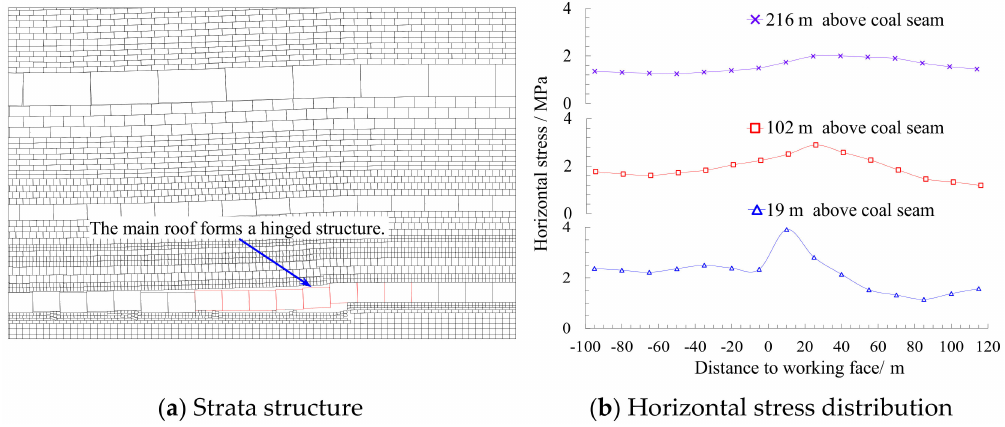
Figure 8. The failure pattern and stress measurements for the overburden after the 1st layer